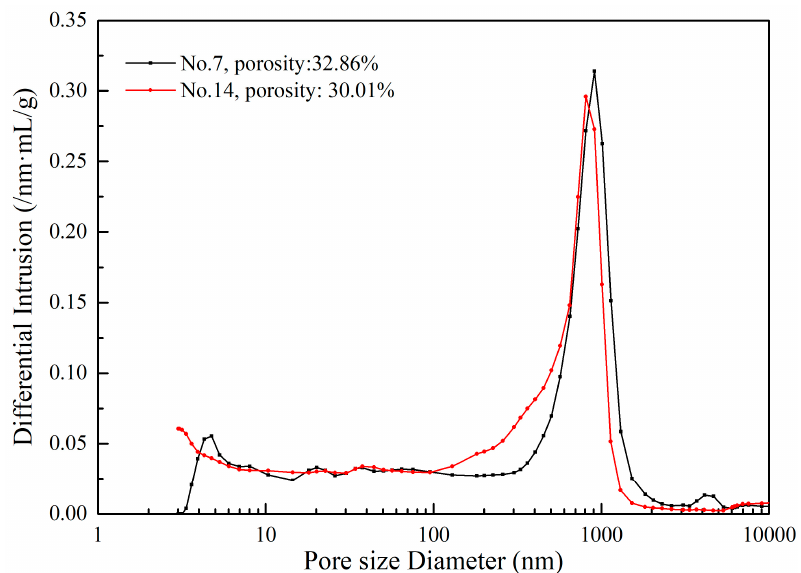
Figure 6. The porosity and pore size distribution of geopolymers synthesized with different alkali